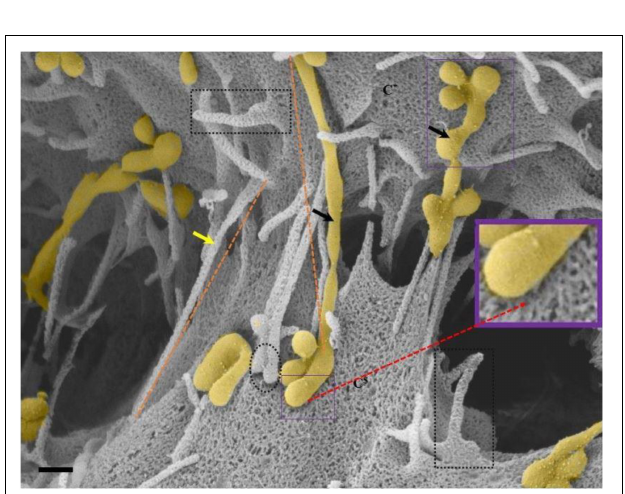
FIGURE 6 | An HRSEM micrograph of two BECs utilizing TENTs to facilitate occlusion of the PC space (Scale bar = 200 nm). Proximal ends of short developing TENTs ( perforated rectangles ) are observed alongside fully extended and developing TUNTs, on each of the juxtaposed lateral membrane surfaces of two BECs in close proximity. TENTs are indicated by the “ yellow arrow, ” its distal ends are indicated by “ black perforated circles ” and TUNTs are indicated by the “ black arrows .” The proximal and distal ends of TUNTs are indicated by the “ solid purple squares .” The micrograph depicts the interplay between flanked TENTs and TUNTs which results in the continuity of BEC membrane topography.